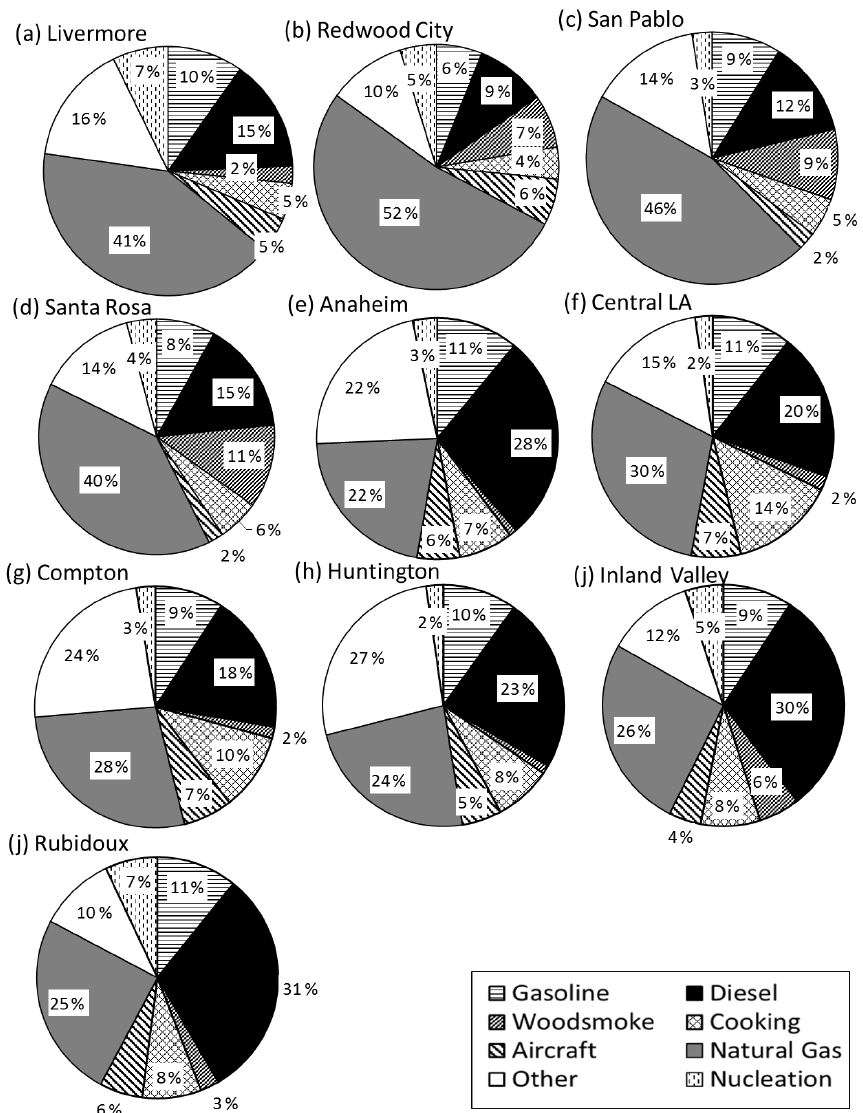
Figure 14. The relative source contributions to PM 0 . 1 seasonally averaged at Livermore, Redwood City, San Pablo, Santa Rosa, Anaheim, central LA, Compton, Huntington, Inland Valley, and Rubidoux, respectively. Averaging time included all days shown in Figs. 10–12. Values not displayed are ≤